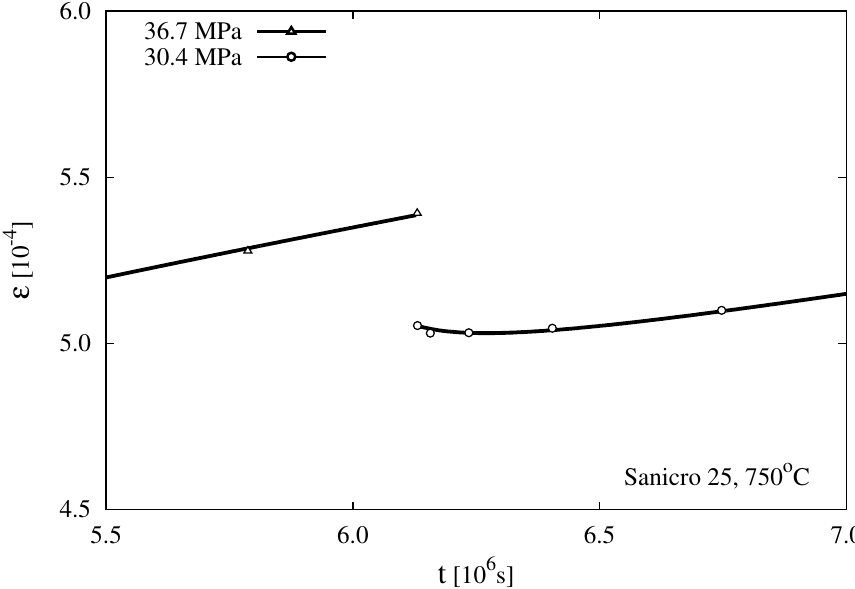
Figure 3. Detail of the creep curve at 750 ◦ C and stress reduction from 36.7 to 30.4MPa. The data required to reproduce these findings are available to download from http://dx.doi.org/ 10.17632/bjw2mtgswp.1#file-a218d703-a6a8-49f7-b765-2080252c050a.